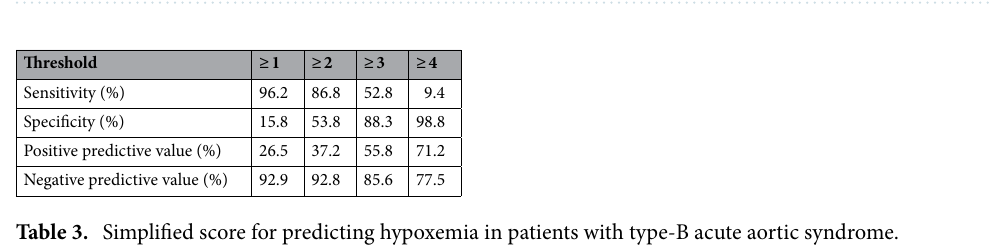
Figure 4. Agreement between the threshold of simplified score and the observed frequency.